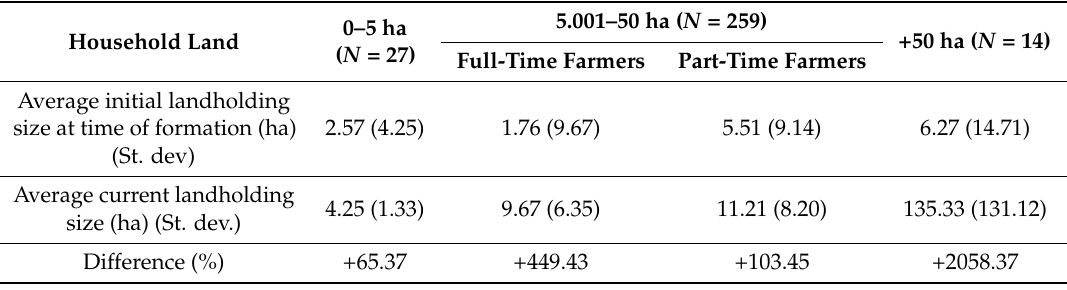
Table 5. Evolution of sampled medium-scale farmers’ * landholding size, in Mchinji, Kasungu and Lilongwe.